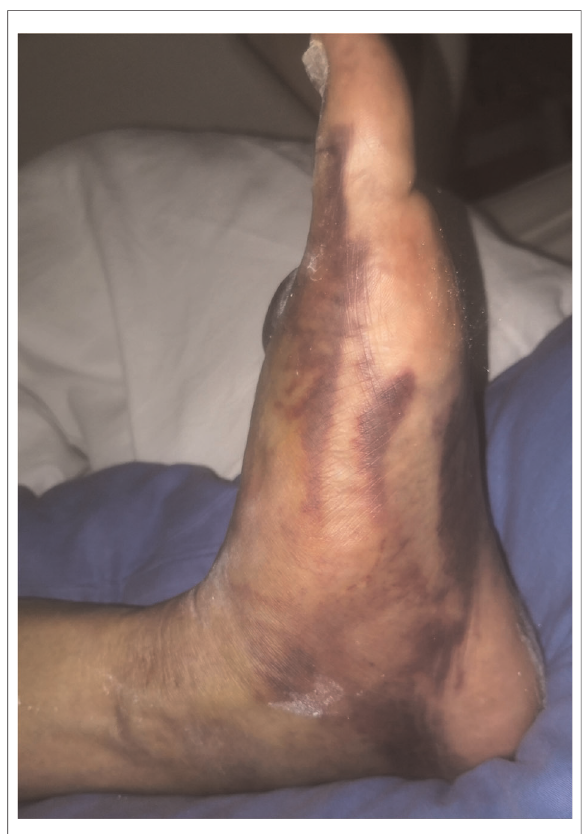
FIGURE 5 A patient admitted with severe swelling of the affected limb with dorsal foot skin blisters and extremely poor soft tissue